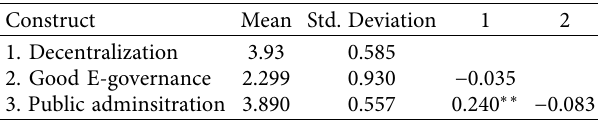
Table 2: Mean, standard deviation, and correlations among the